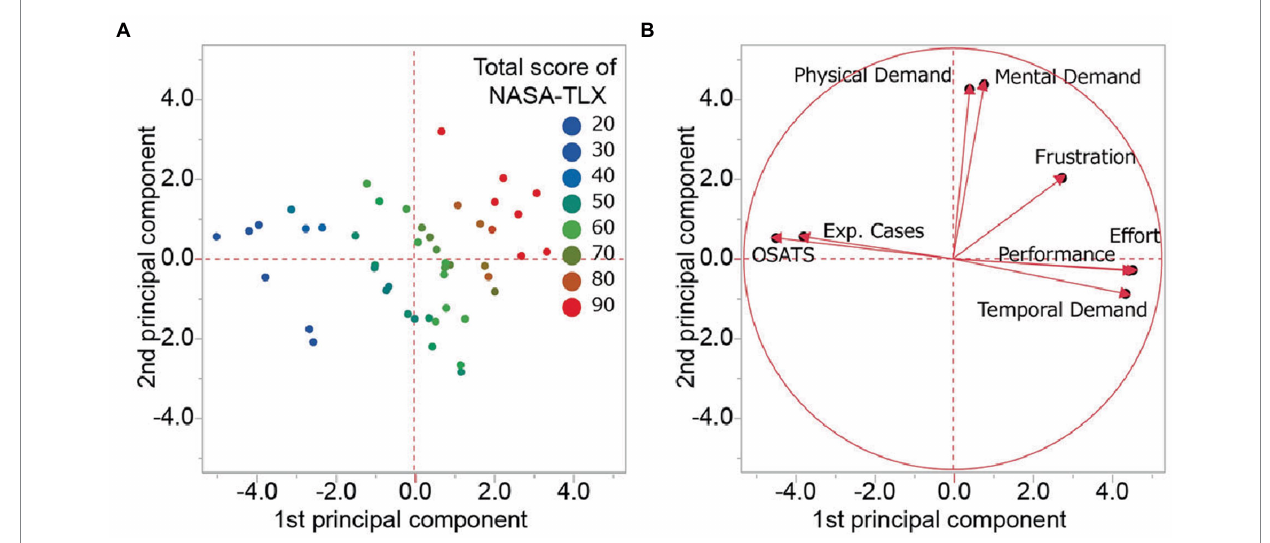
FIGURE 4 Principal component analysis regarding the surgical skill level and mental workload. (A) The principal component score plot on each surgeon. The color represents the total score of NASA-TLX (red; high, green; middle, and blue low). (B) The Loading plots of 1st and 2nd principal components. NASA-TLX, national aeronautics and space administration-task load index; Exp. Cases, experienced cases; OSATS, objective structured assessment of technical skills.